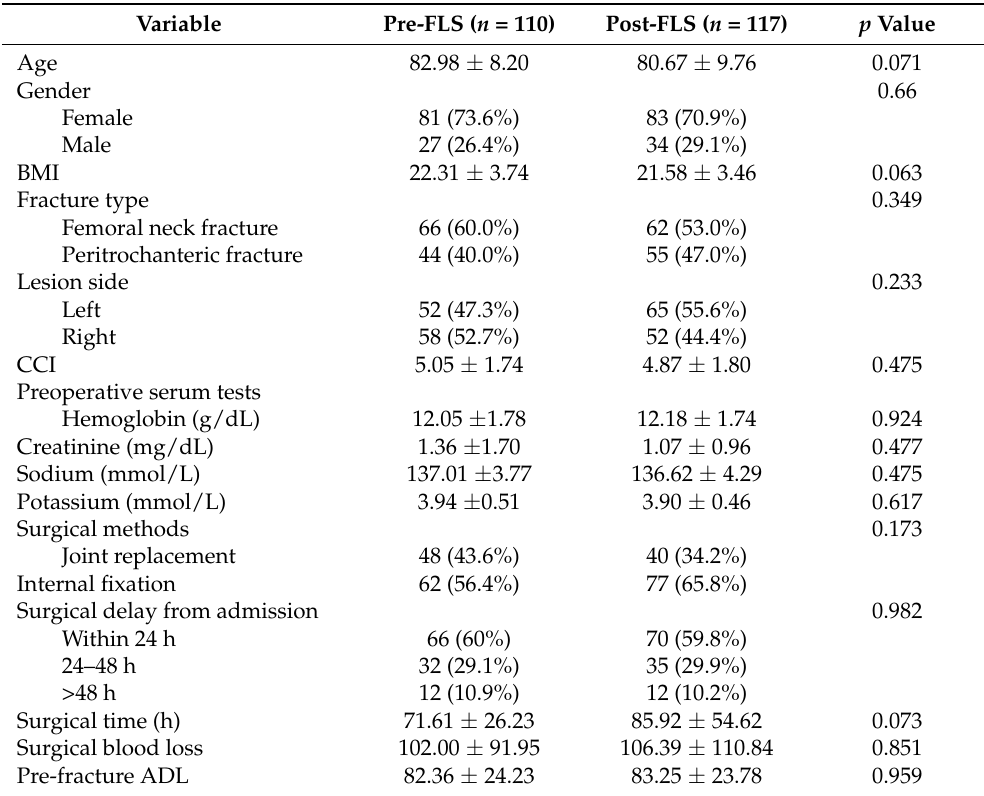
Table 1. Basic characteristics of patients in the pre-FLS and post-FLS groups.